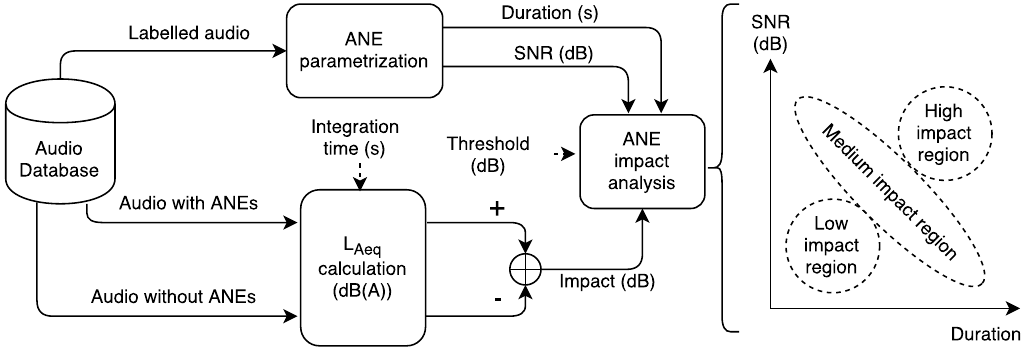
Figure 1. Block diagram of the methodology used to analyze the impact contribution of the Anomalous Noise Events (ANEs) to the L Aeq considering the Signal-to-Noise Ratio (SNR) and the duration of the anomalous event. The analysis includes three regions: ( a ) high-impact, due to ANEs with high SNR and long duration; ( b ) low-impact, due to ANEs with low SNR and short duration; and ( c ) medium impact, which integrates those ANEs falling in between the previous two